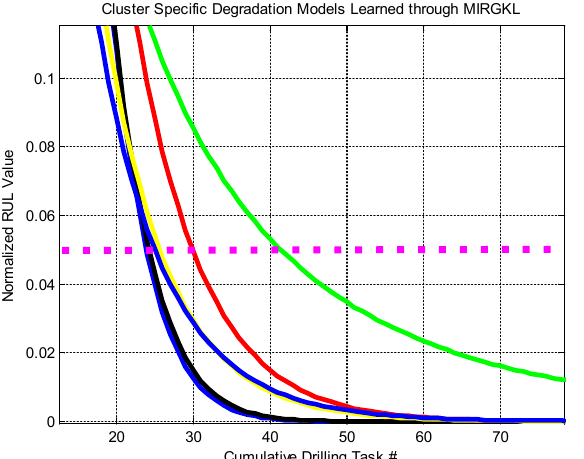
Figure 12. Zoom-in view of Figure 11. Each color represents one specific cluster’s learned degradation profile. Pink dotted line is the threshold for RUL prediction.